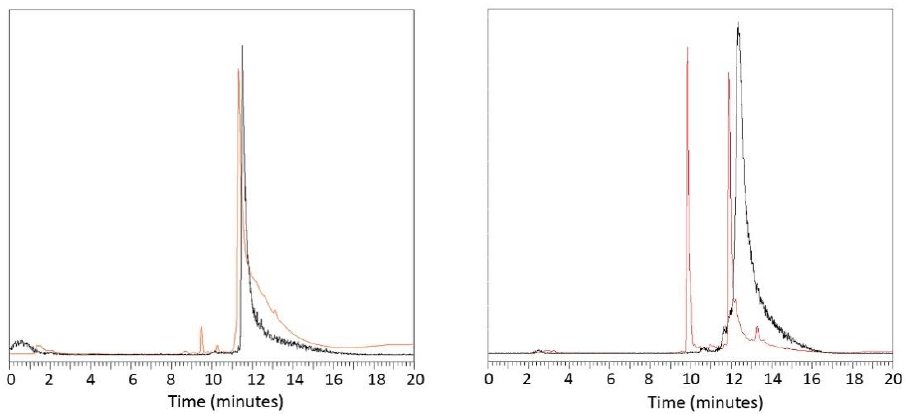
Figure 4. Chromatograms of Tc-99m complexes (black color, radiometric detector; ( left ) 2 Tc , ( right ) 3 Tc ) and their homologous rhenium complexes (red color, UV detector; ( left ) 2 Re , ( right ) 3 Re ). UV signal of 3 Re chromatograms was obtained from the complex prepared in DMSO at milligram level; therefore, only in this case is the peak at 10.0 min evident which corresponds to the presence of 3 Zn .